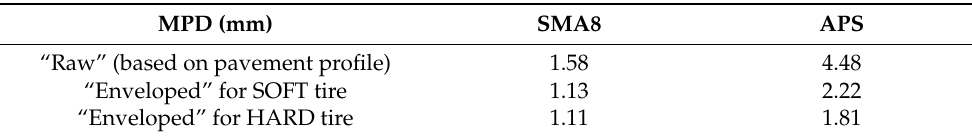
Table 1. Comparison of “enveloped MPD” for tested slick tires with MPD calculated on the base of raw pavement profile.